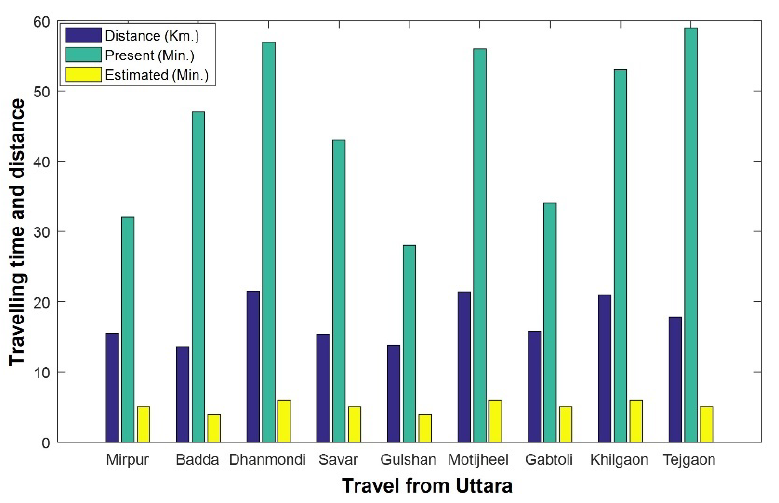
Figure 10. Comparison of traveling time for the distance between Uttara to different places in Dhaka.